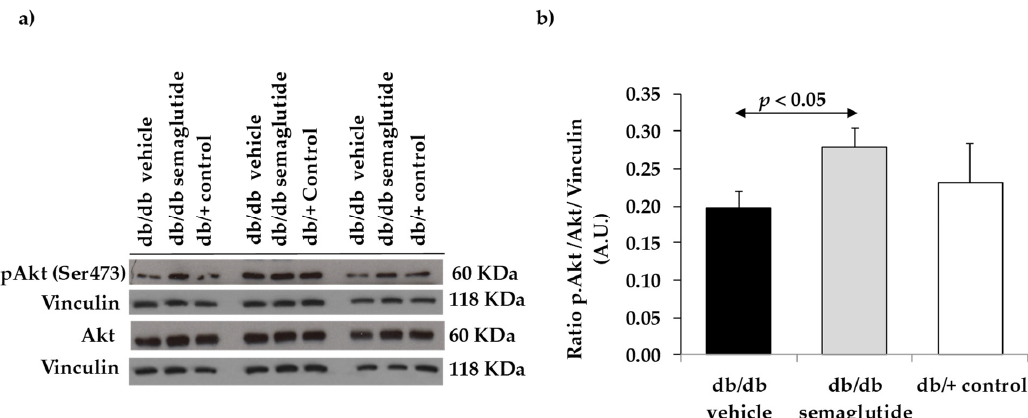
Figure 4. Effect of semaglutide eye drops on cell survival. ( a ) Western blotting bands of phospho-Akt/Akt. ( b ) Densitometric analyses in mouse retinas of db/db mice treated with vehicle (black bars), db/db mice treated with semaglutide eye drops (grey bars) and non-diabetic mice (white bars).